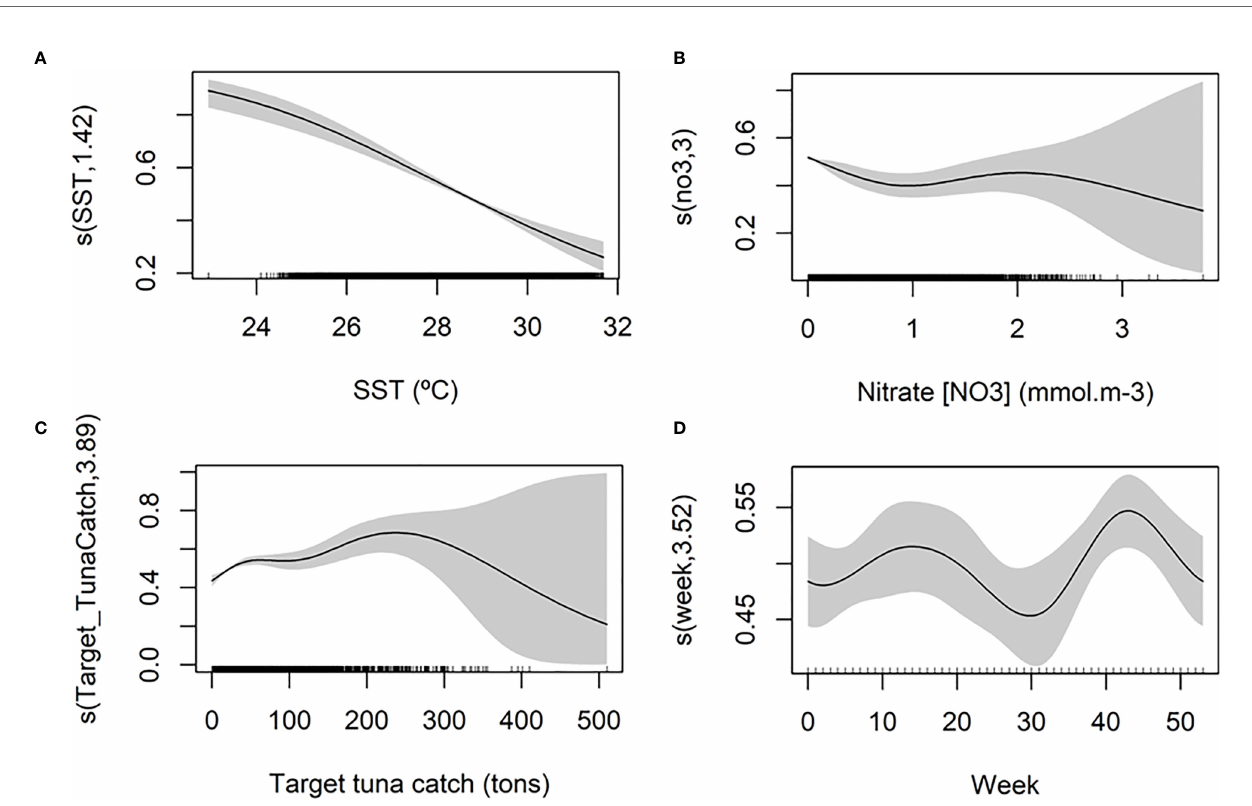
FIGURE 4 | Partial effects of four predictor variables in the fi nal model for predicting the catch probability of an oceanic whitetip shark. (A) Sea surface temperature (SST) (°C), (B) nitrate (mmol.m -3 ), (C) target tuna catch (tons) and (D) week. Effect size for each variable is expressed in probability units (0-1) and indicates the